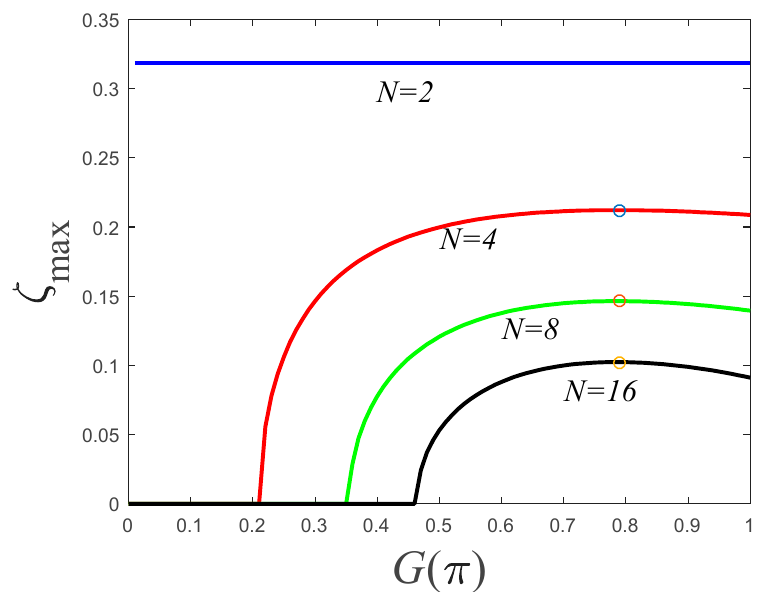
Figure 5. Evaluation of ζ max as a function of the filter’s spectral amplitude at first harmonics G ( π ) for N = 2, 4, 8, and 16. The maximum value G ( π ) = π /4 is marked by circles. This function reaches its maximum value at G ( π ) = π /4 (regardless of the number of levels, N ), for which case, we finally obtain a simple expression for the maximum